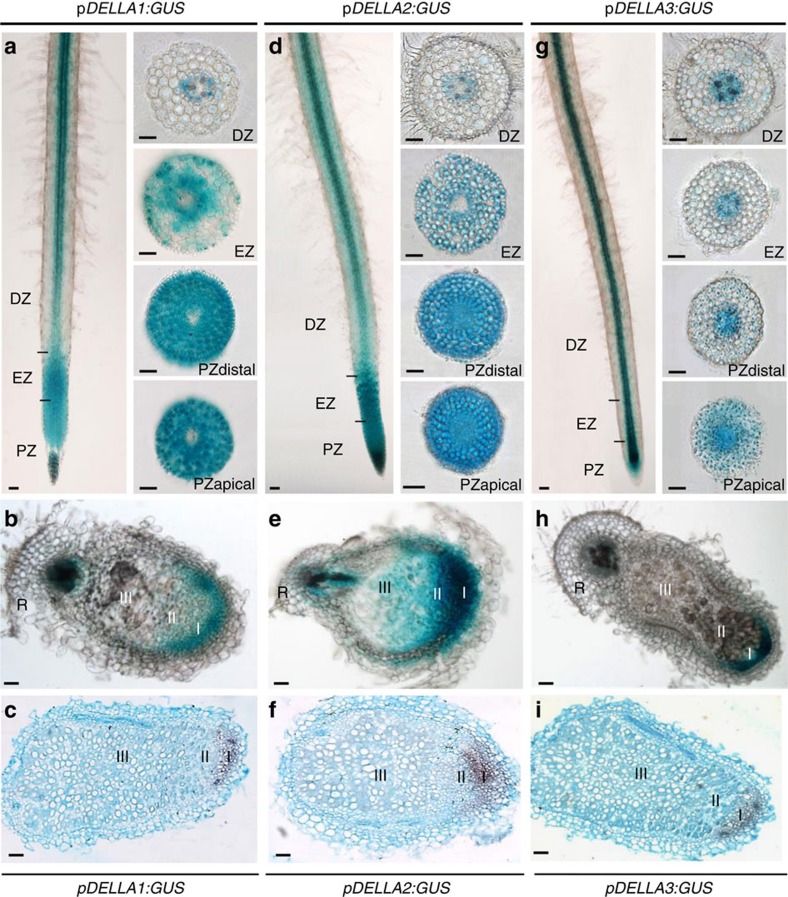
DELLA expression patterns in M. truncatula roots inoculated with rhizobium and symbiotic nodules.Histochemical analysis of GUS activity of MtDELLA transcriptional fusions in roots (1 day post inoculation (dpi) with S. meliloti) and nodules (21 dpi). Whole roots or 40 μm thick transversal root and nodule sagittal sections of MtDELLA1:GUS (a,b), MtDELLA2:GUS (d,e) and MtDELLA3:GUS (g,h) are shown. (c,f,i) are in situ hybridizations of MtDELLA1 (c), MtDELLA2 (f) and MtDELLA3 (i) transcripts in 40 μm thick nodule longitudinal sections. Root zones are described as follows: DZ, differentiation zone; EZ, elongation zone; PZ, proliferation zone. Nodule zones are described as follows: I, meristem; II, infection/differentiation zone; III, nitrogen-fixation zone (according to Vasse et al.7); R, root. Scale bars, 100 μm. One representative example out of n=20 independent roots for histochemical analysis of GUS activity and n=5 nodules for in situ hybridization is shown.